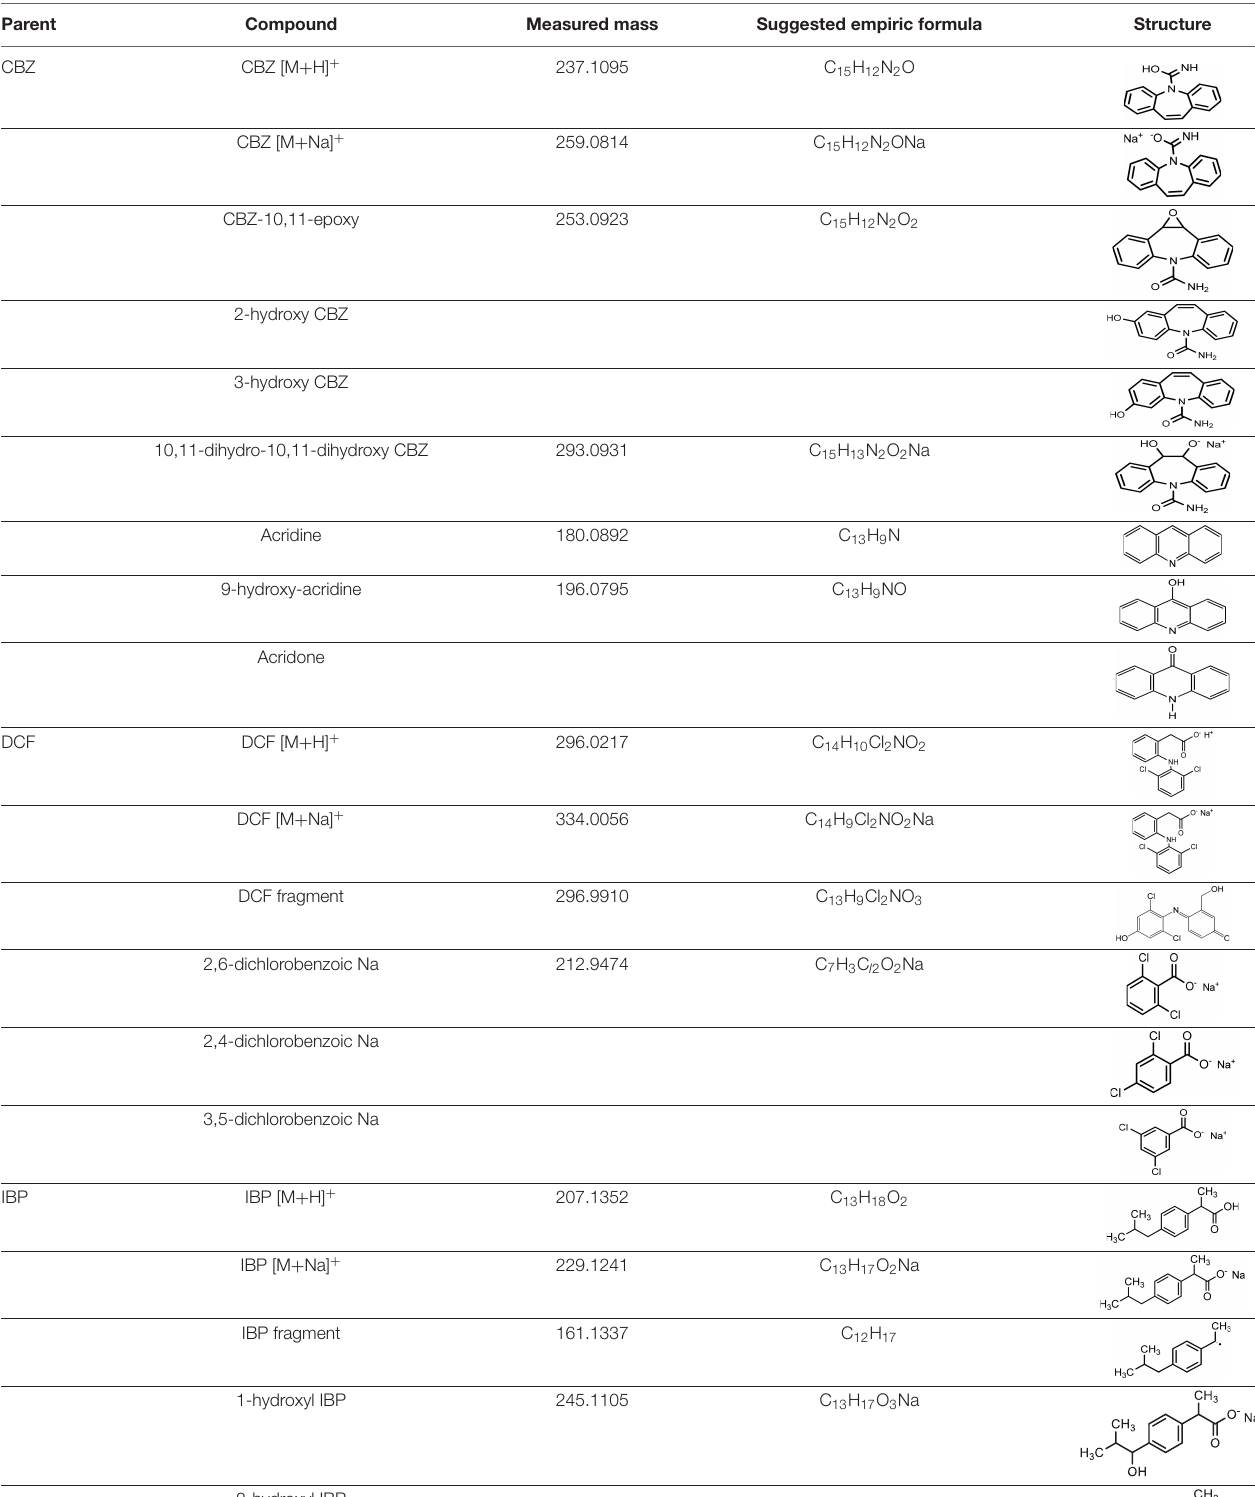
TABLE 3 | Accurate mass measurements attributed to molecular ions of the parent compounds and intermediates from CBZ, DCF, and IBP determined by UPLC-( + )-ESI-QT oF-MS. Parent Compound Measured mass Suggested empiric formula